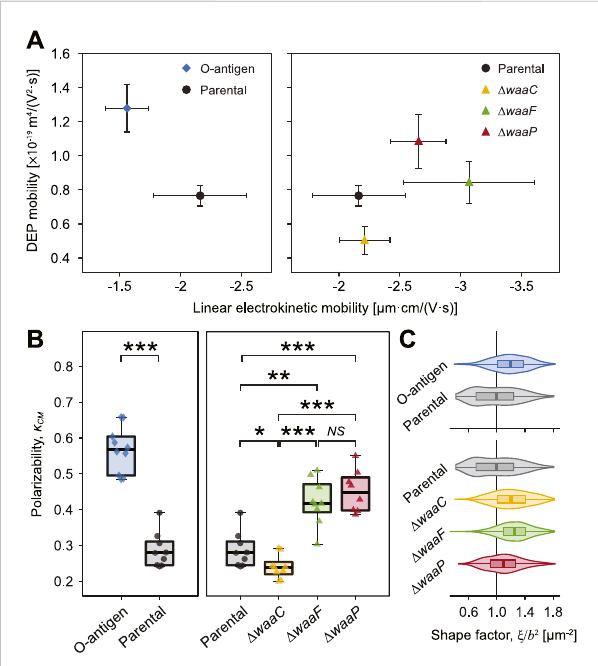
Strong correlation between E. coli LPS structural variations, DEP mobilities, and polarizability. (A) Plot of measured DEP mobilities against linear electrokinetic mobilities for each strain indicates that E. coli expressing O-antigen (diamond, left) and core synthesis mutants (triangles, right) clearly deviate from the parental strain (circle). Error bars indicate standard deviations. Statisticaldifference of DEP mobilities is shown in Supplementary Figure S8. (B) Cell polarizability, as measured by the Clausius-Mossotti factor ( κ CM ) of each strain. Asterisks indicate statistical difference (* p < 0.02, ** p < 0.005, and *** p < 0.001, NS: not signi fi cant). (C) Cell shape factor, ξ / b 2 , of studied strains, where ξ is the Perrin friction factor (Koenig, 1975) and b is the short semi-axis of the cell. The shape factor represents how much the ellipsoidal cell shape in fl uences the drag force versus the DEP force. See Supplementary Section 3.2 for a detailed